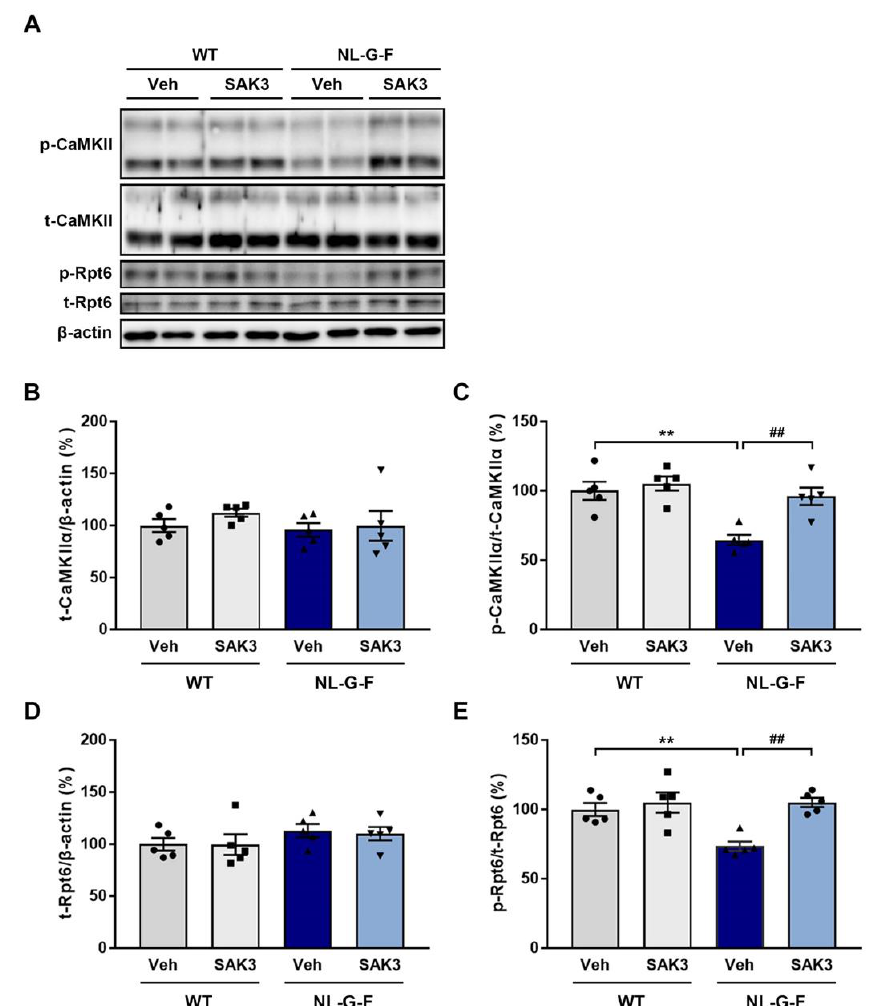
Figure 3. SAK3 administration improves CaMKII-Rpt6 signaling in NL-G-F mice. ( A ) Representative image of western blot membranes containing hippocampal protein probed with antibodies against autophosphorylated CaMKII (T286), CaMKII, phosphorylated Rpt6 (S120), Rpt6, and β -actin. ( B ) Quantitative analyses of CaMKII α , ( C ) autophosphorylated CaMKII α (T286), ( D ) Rpt6, and ( E ) phosphorylated Rpt6 (S129) protein levels ( n = 5 per group); autophosphorylated CaMKII α : F (3, 16) = 11.01, p < 0.01; phosphorylated Rpt6: F (3, 16) = 9.316, p < 0.01. Error bars represent SEM. ** p < 0.01 vs. vehicle-treated WT mice; ## p < 0.01 vs. vehicle-treated NL-G-F mice. The symbols (solid dots, squares, triangles and inverted triangle) indicate the individual